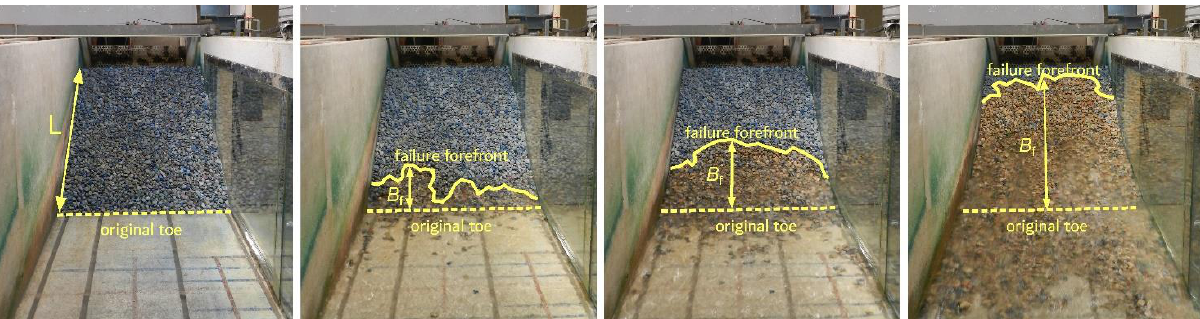
Figure 2. Scheme of the failure process sequence for discharges of 0 , 0.0188 , 0.0256 , and 0.0423 m 3 s −1 (test nº 133 , 𝐻 = 1 m , 𝑊 = 1.32 m , 𝑍 dss = 1.6 , gravel M7